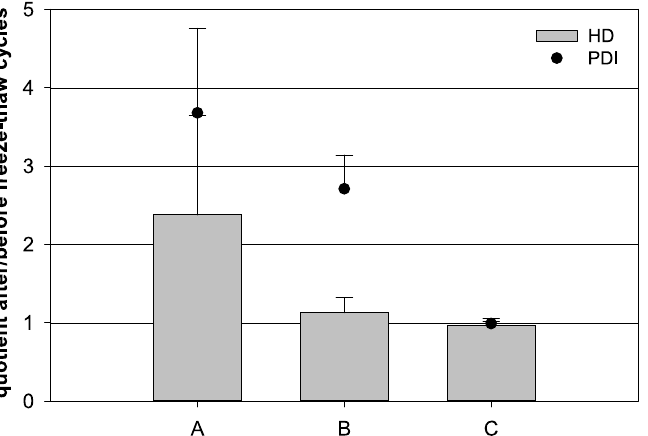
Figure 2. Influence of freeze–thaw cycles on the quotient of the hydrodynamic diameter (HD, bars) and the quotient of the polydispersity index (PDI, dots) before and after a freeze–thaw cycle, respectively. (A) 100 µ L nanocapsule suspension with 900 µ L purified water, (B) 1000 µ L nanocapsule